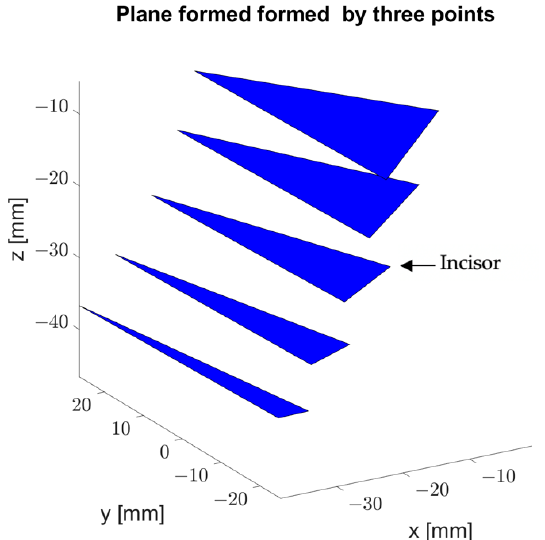
Figure 7. 3D visualization of the plane formed by the three active sensors. The incline of the plane in each measurement is observed.